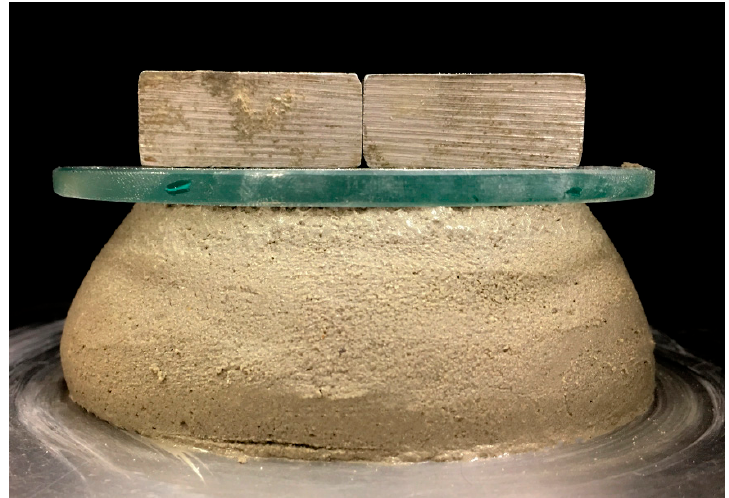
Figure 3. The shape-retention ability test setup.